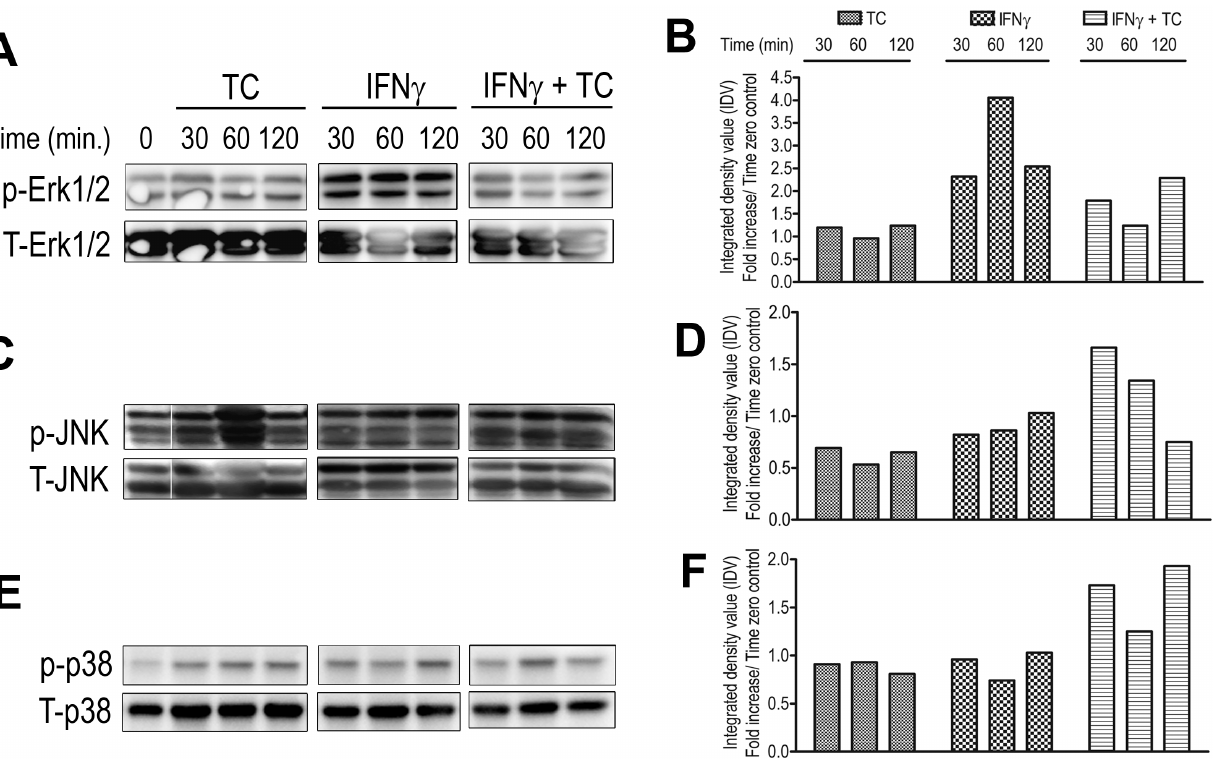
Figure 2. TC-WCE modulates IFN c -induced MAPK Phosphorylation in ANA-1 cells. Macrophage cells (ANA-1) from relatively resistant C57BL/6 mice were serum-deprived for 24 h and stimulated with IFN- c and TC in combination or alone. Cells were washed, and cell lysates were collected at indicated times. Erk1/2, JNK, and p38 MAPK phosphorylation (A, C, E) was assessed by Western blotting. The membranes were then stripped and re-probed for total (T) MAPK. Phosphorylation intensity was quantified by densitometry and presented in panels beside the blots as fold-increase in phosphorylation normalized with total MAPKs over time zero (B, D, F). Data presented are representative of 3 different experiments with similar findings.